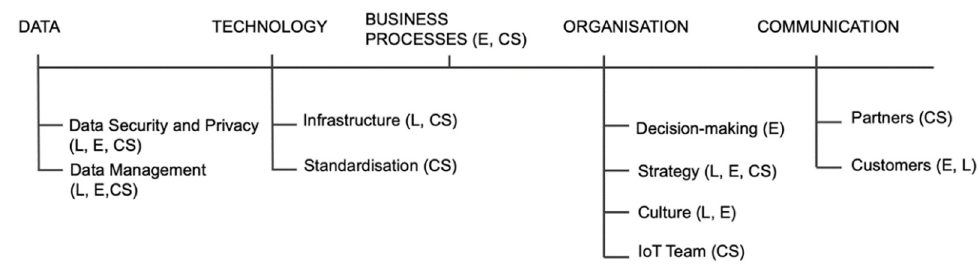
Figure 1. Initial